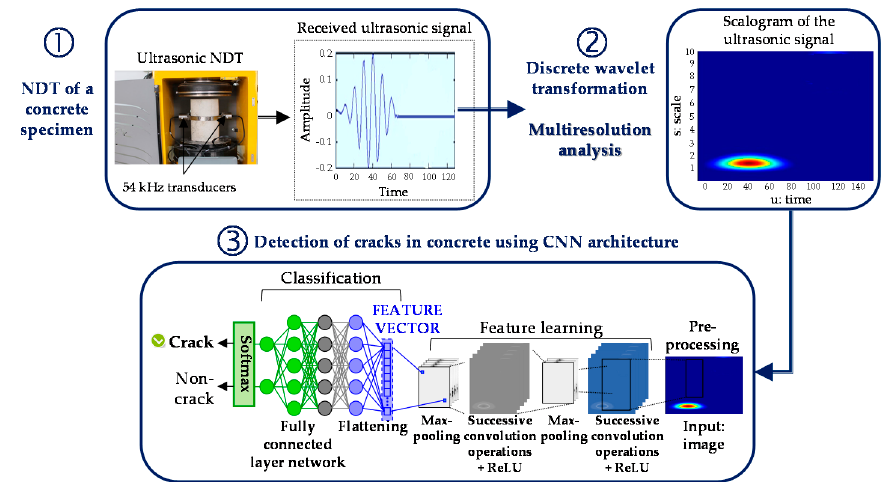
Figure 14. Flow chart of our methodology for the detection of cracks in concrete.